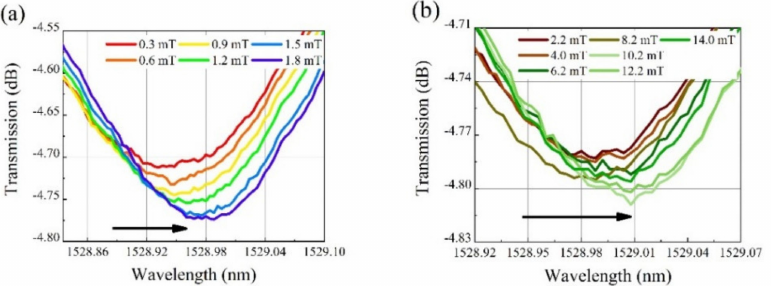
Figure 6. Transmission spectra at different magnetic field intensities for the PCF microcavity with diameter of 75 µ m. The magnetic field strength is in the range of ( a ) 0.3 to 1.8 mT and ( b ) 2.2 to 14